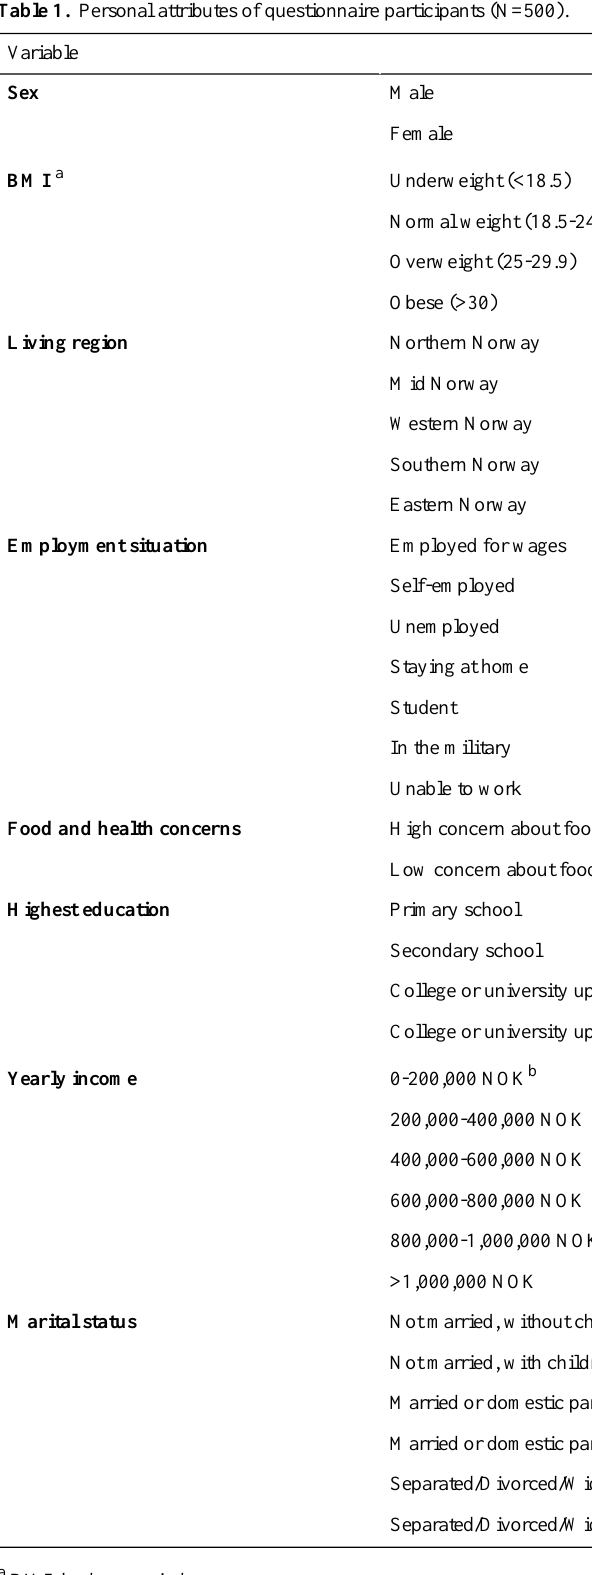
Table 1. Personal attributes of questionnaire participants